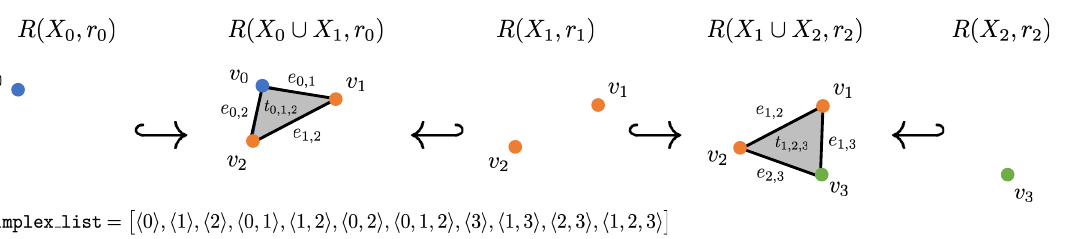
Figure 3. Example zigzag using fixed radius with computed inputs for Dionysus.